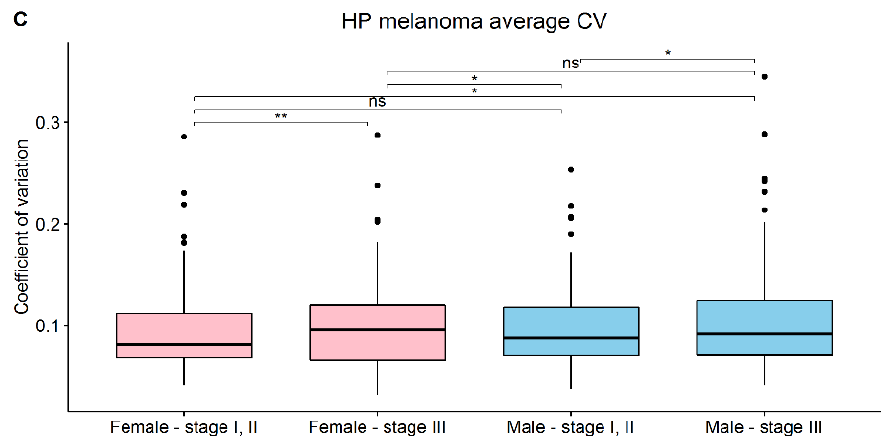
Figure 3. Boxplots on the sex/stage stratifications were constructed on ( A ) CVs of the gene signature for GOBP_skin_development, ( B ) gene expression averages of the gene signature for GOBP_skin_development, and ( C ) CVs of the gene signature for HP_melanoma. ns = not significant, * p < 0.05, ** p < 0.01, *** p < 0.001, **** p < 0.0001.